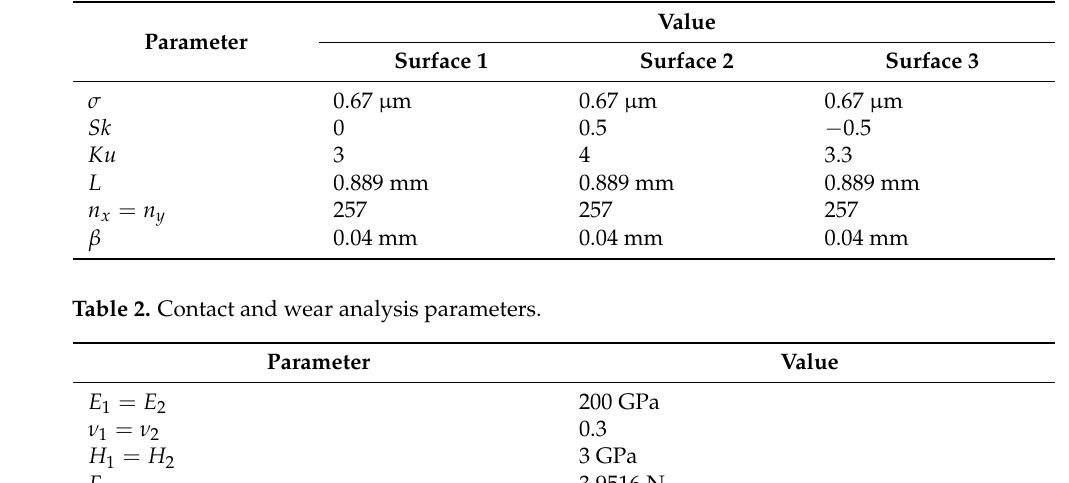
Table 1. Rough surface generation parameters.